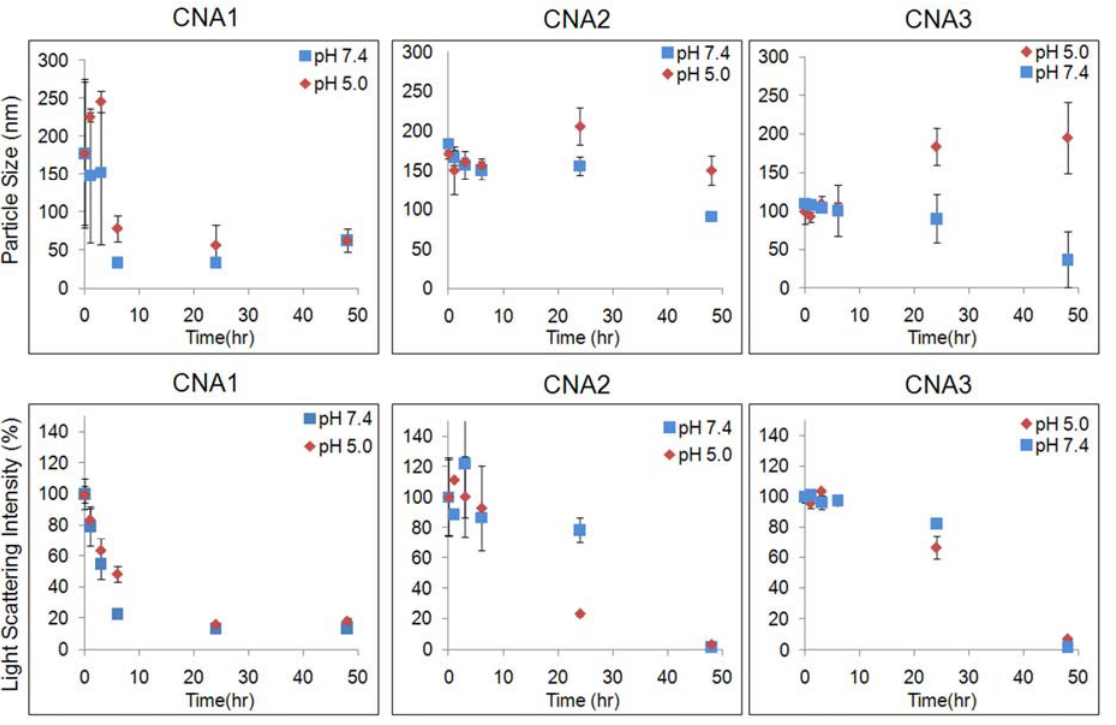
Figure 2. Time-dependent changes in particle sizes and light scattering intensity of